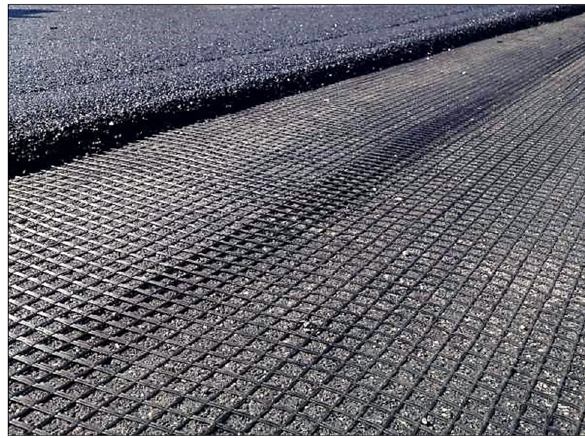
Figure 4: Polypropylene biaxial geotextile.